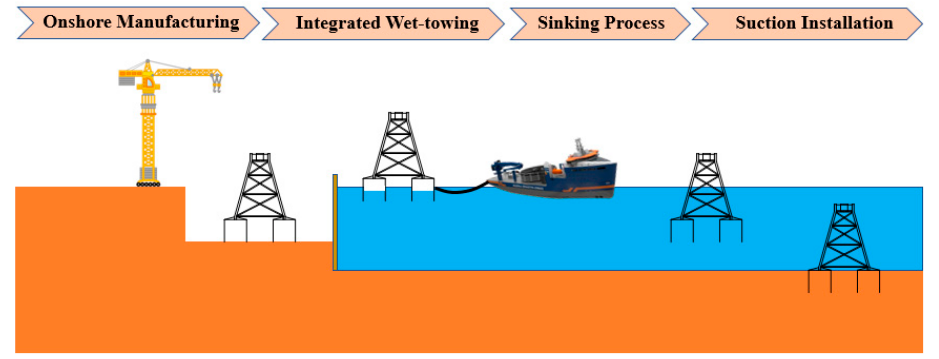
Figure 4. Manufacturing and wet ‐